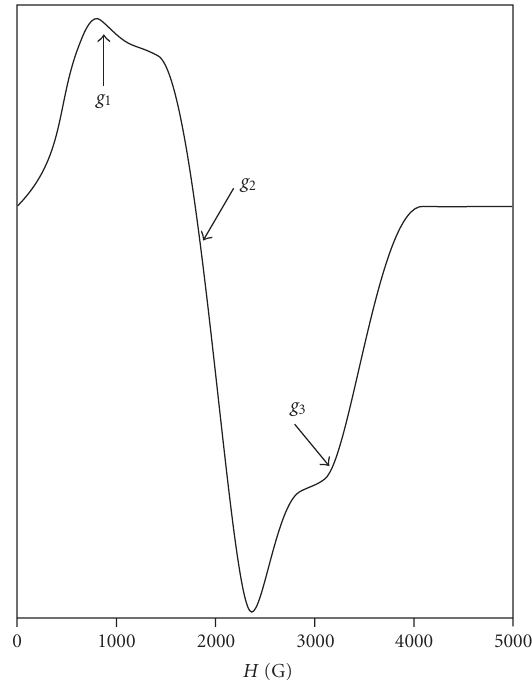
Figure 2: X-band spectrum of compound 4 . EPR conditions: microwave frequency 9.407 GHz, temperature 4.2 K, mod. ampl. 8 Gpp, microwave power 0.6 mW, sweep time 200 seconds, t.c.: 300 milliseconds. The arrows indicate regions of g